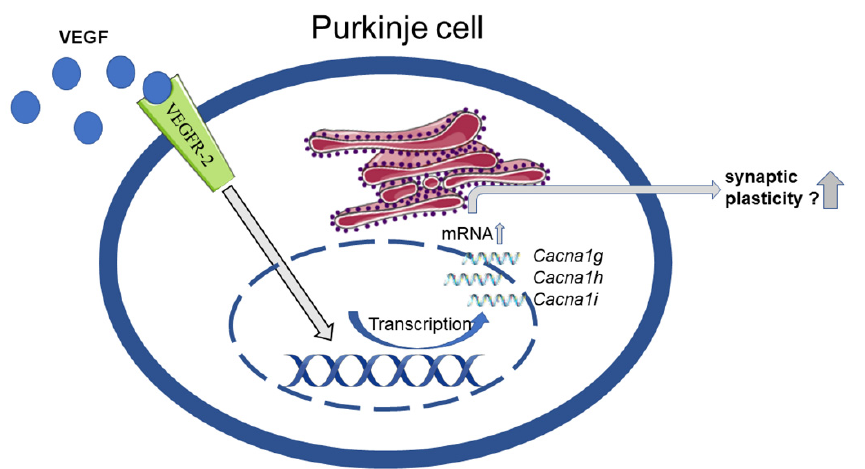
Figure 8. Schematic overview of the conceptualized effects of VEGF on PCs. VEGF binds to and activates VEGFR-2, followed by an intracellular signaling cascade, with consequent increase of T-type Ca 2+ channel mRNA. It is possible that these increased levels of T-type Ca 2+ channel mRNA enable the PC to implement synaptic plasticity more easily.